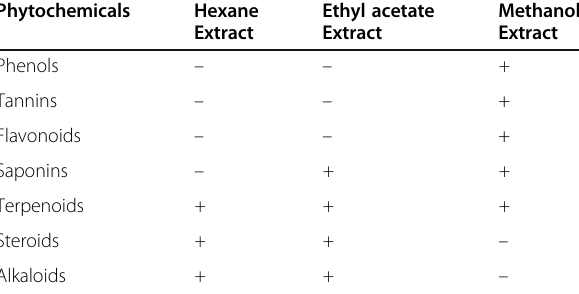
Table 1 The various classes of phytochemicals present in the crude extracts of Desmodium canum Phytochemicals Hexane Ethyl acetate Extract Extract